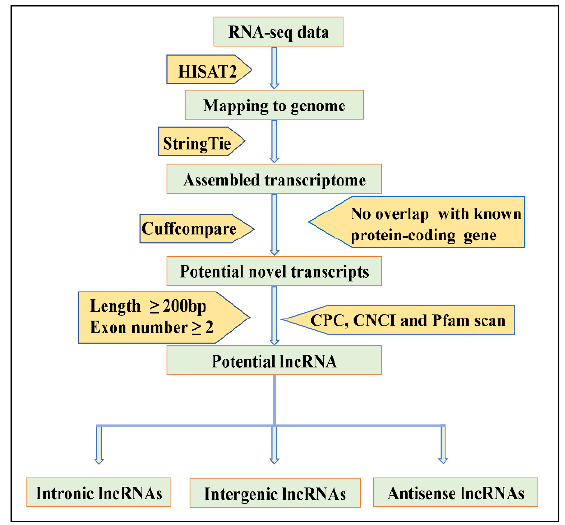
Figure 1. Identification of the putative lncRNAs. The detailed step of filtering pipeline is depicted in the methods section.